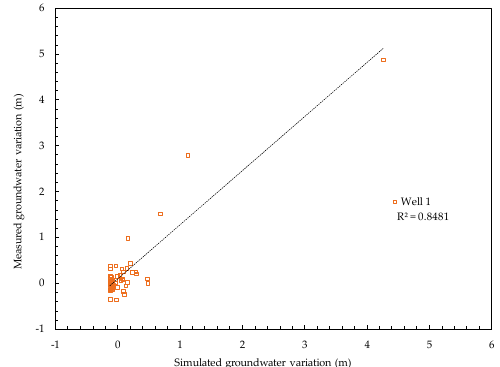
Figure 6. The model testing correlation relationship of Well 1.